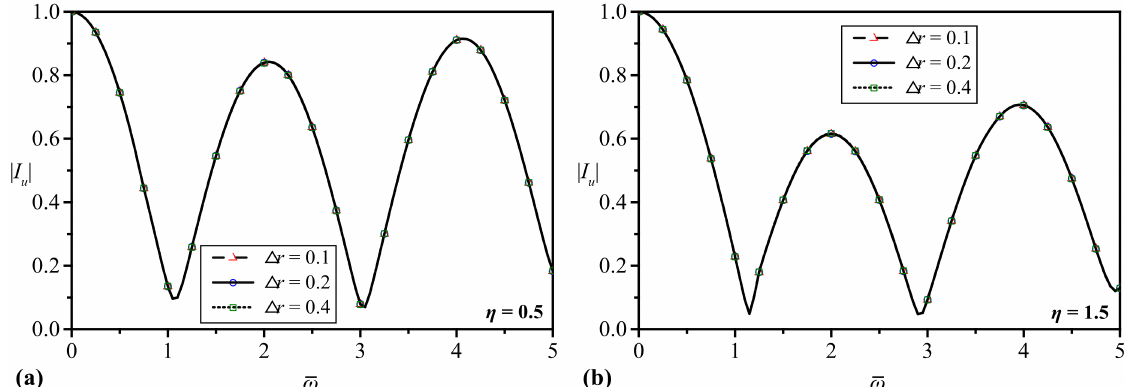
Figure 5. The effects of the disturbance range ( (cid:52) r ) on the kinematic response and amplification factors of piles ( ρ p = 2500 kg/m 3 , E p = 36 GPa, r 0 = 0.5, υ j = 0.4, β j = 0.2, G N +1 = 36 MPa, H = 20 m). ( a ) Kinematic response factor; ( b ) Amplification